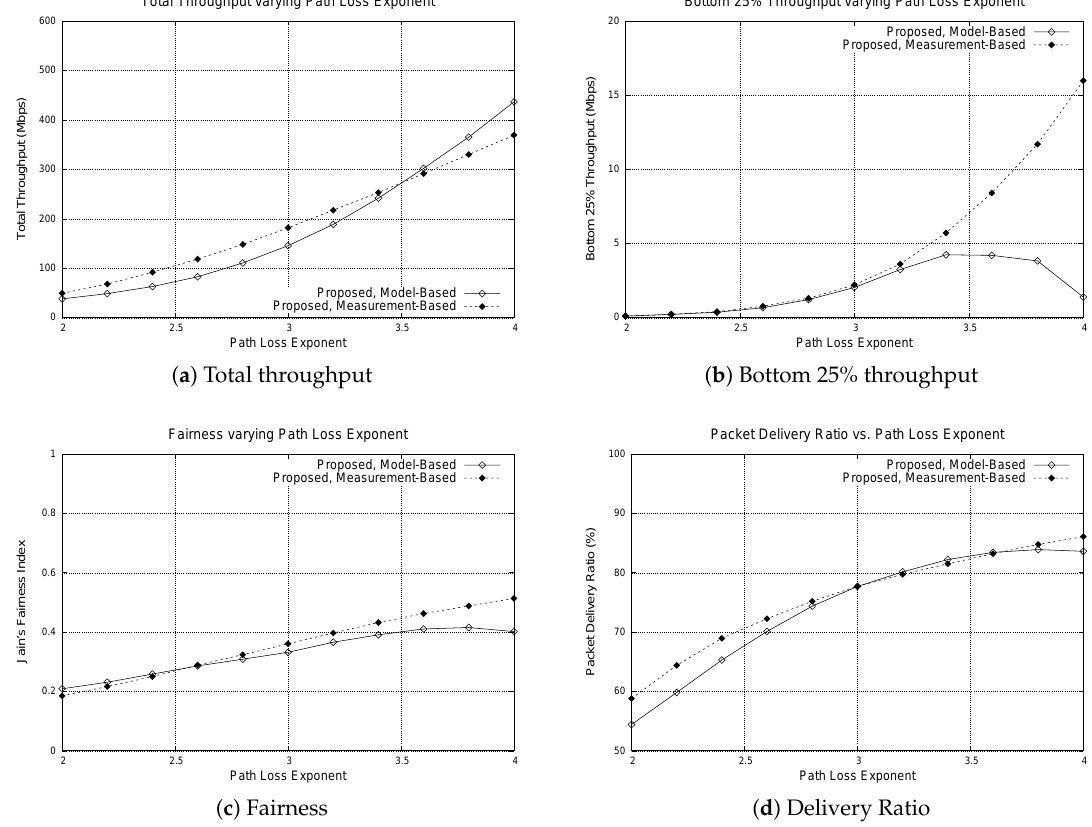
Figure 8. Performance of the model-based scheme and the measurement-based scheme varying path loss exponent γ . For the model-based scheme, the mismatch between the model and the real environment can affect the performance. ( a ) total throughput, ( b ) bottom 25% throughput, ( c ) Jain’s fairness index, ( d ) packet delivery